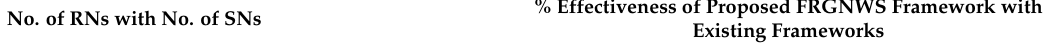
Table 3. The average % effectiveness of the proposed novel framework for the number of RNs metric with variations in the number of SNs. No. of RNs with No. of SNs